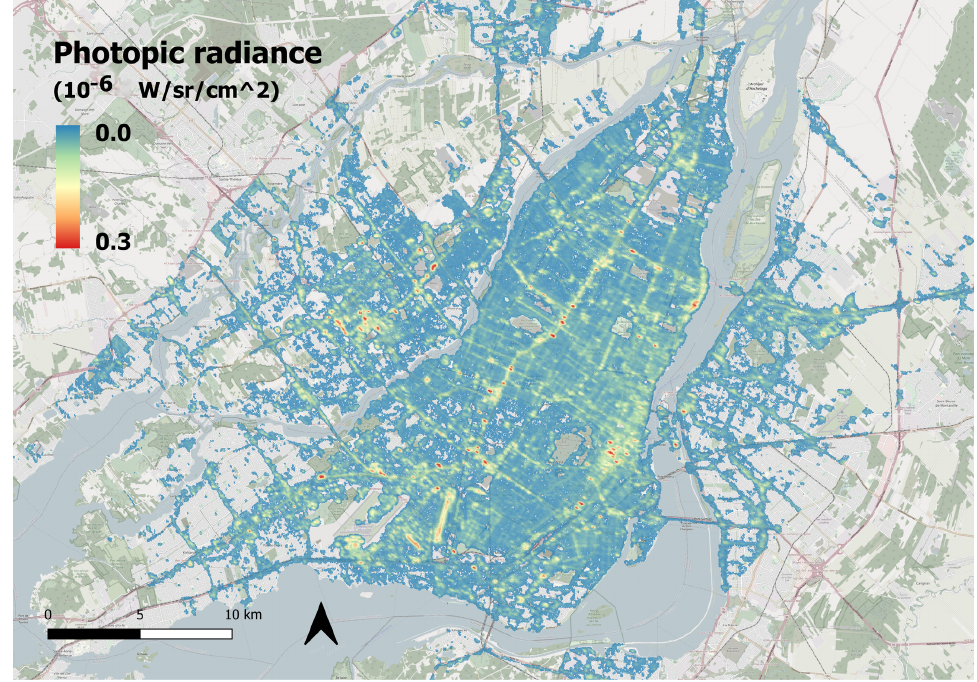
Figure 4. Filtered photopic radiance image of Montréal from the ISS taken on 6 April